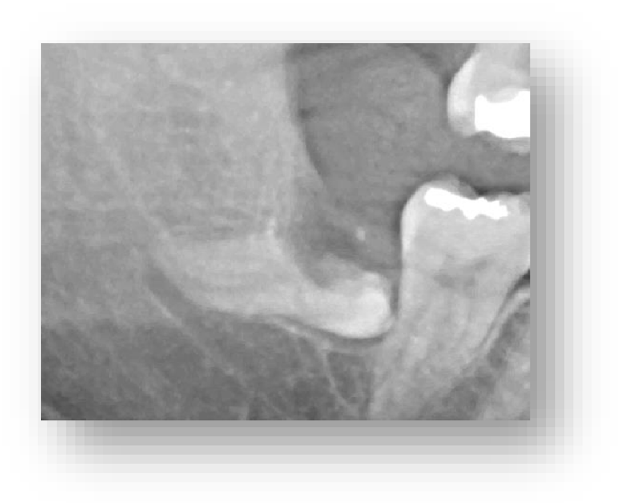
Fig. 3. Failed separation causing the necessity of a new